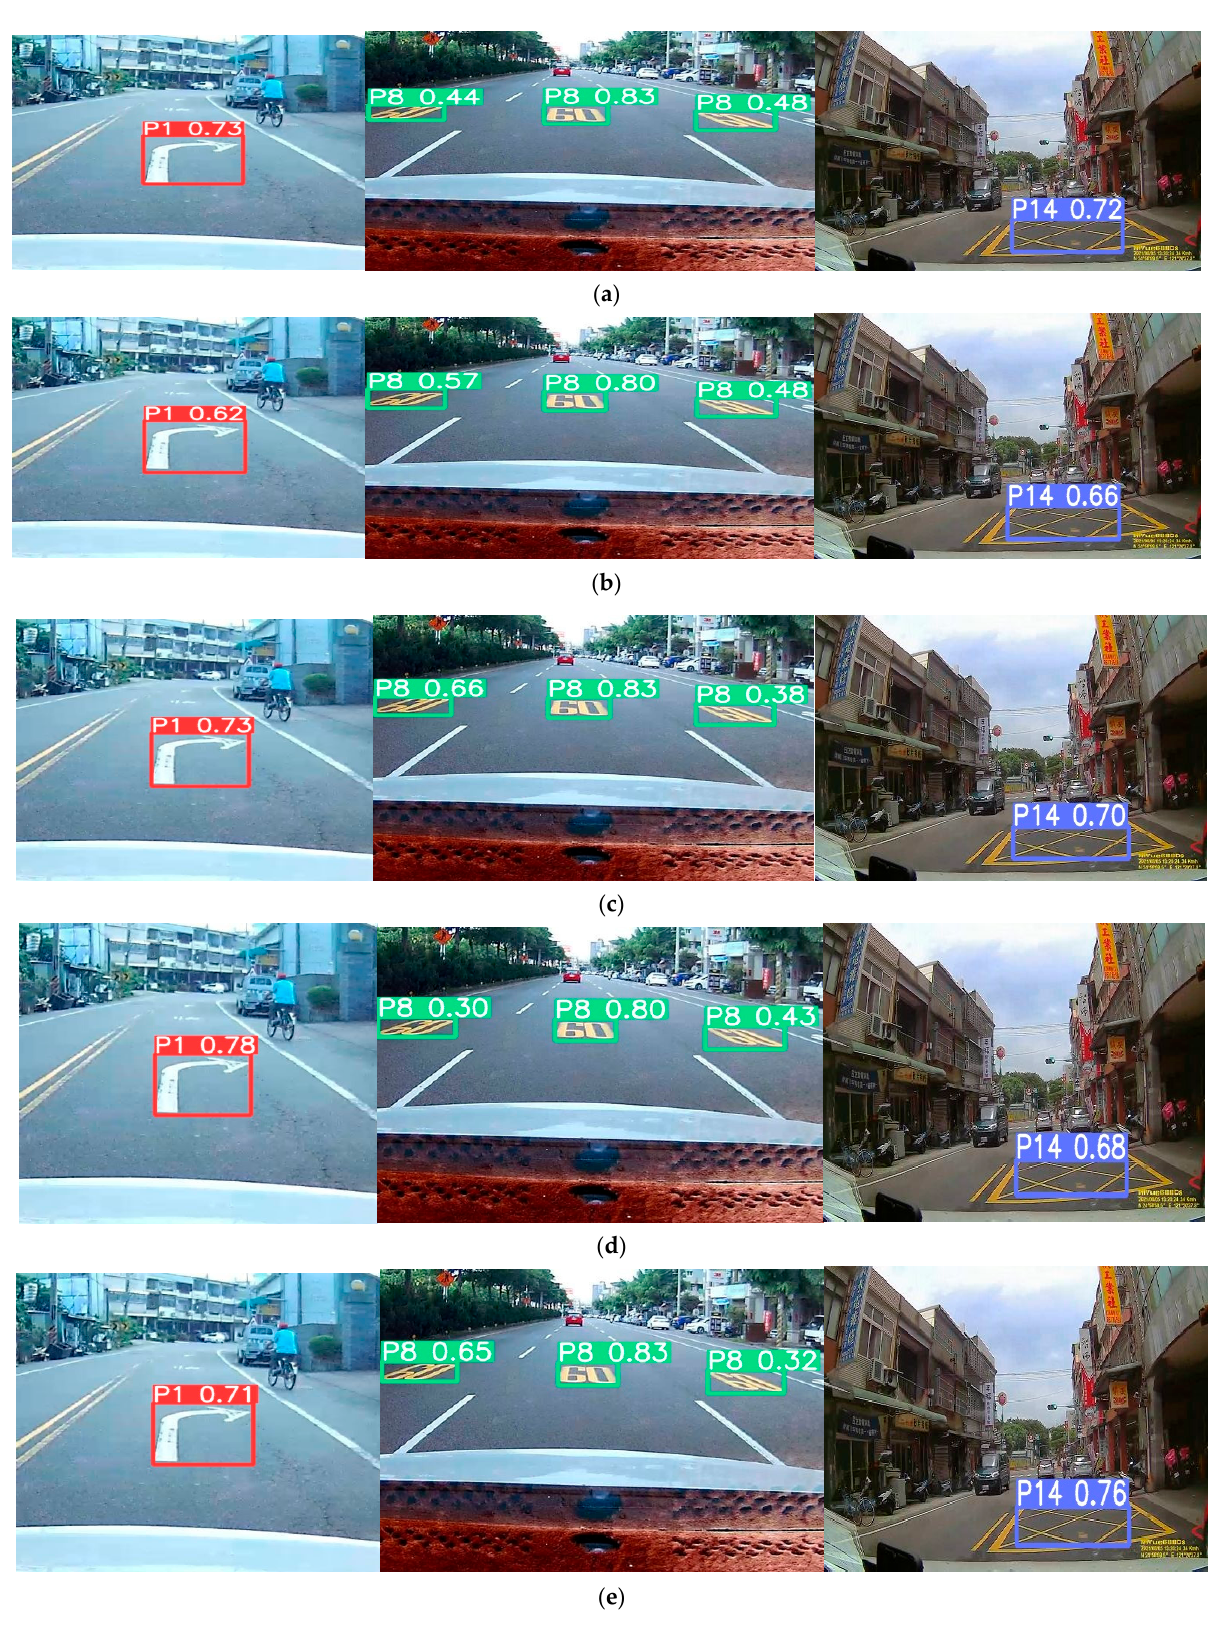
Figure 6. Recognition results. ( a ) Yolov5n, ( b ) Yolov5s, ( c ) Yolov5m, ( d ) Yolov5l, and ( e ) Yolov5x.